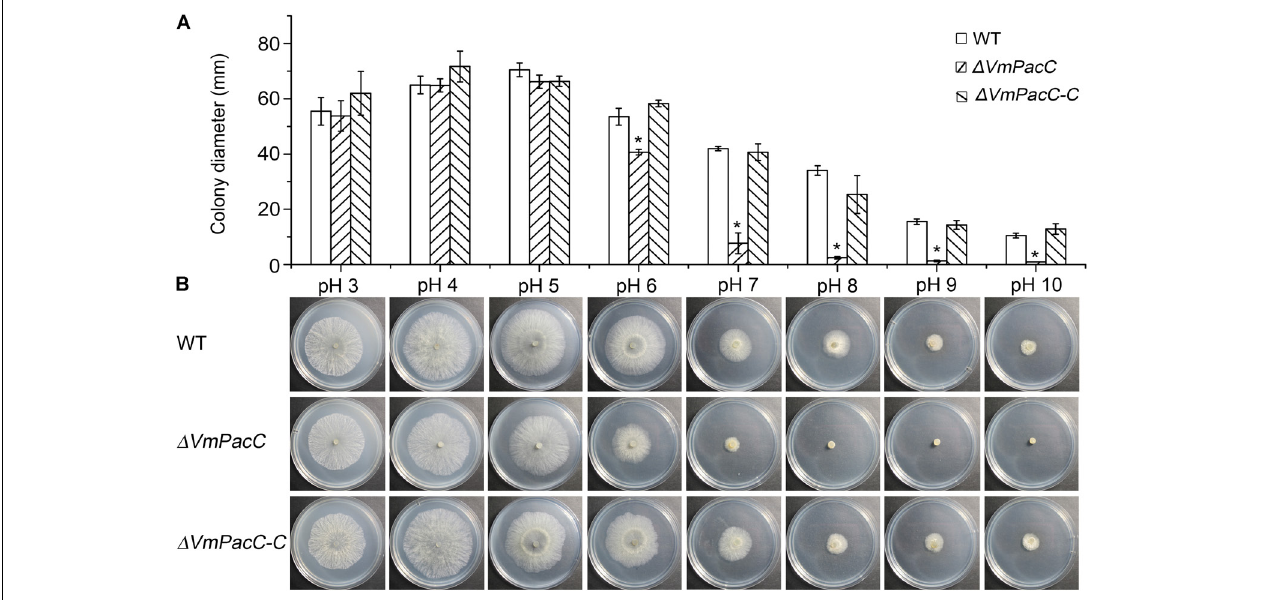
FIGURE 2 | VmPacC is required for adaptation to ambient pH in V. mali . (A) Quantification of growth rate incubated for 2 days at 25 ◦ C. Results are the average of three independent experiments and standard deviations are shown. The asterisk represents a statistically significant difference compared to wild-type ( P < 0.05). (B) Growth of wild-type, VmPacC deletion, and complemented mutant strains in unbuffered potato dextrose agar (PDA) adjusted to pH 3 to pH 10 with HCl or NaOH.